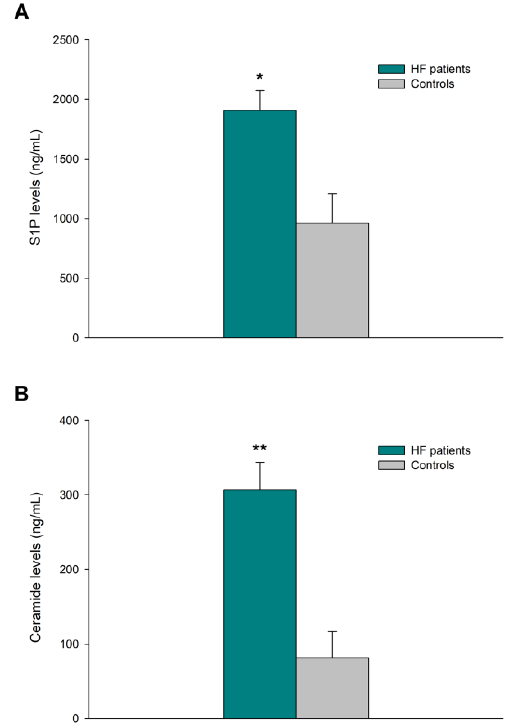
Figure 3. Differential expression of bioactive sphingolipids in cardiac tissue. ( A ) Sphingosine-1-phosphate (S1P) and ( B ) ceramide levels in heart failure (HF) and healthy controls. Data are presented as the mean ± standard error. HF patients ( n = 36; green bars) and controls subjects ( n = 5; gray bars). Mann–Whitney U test: * p < 0.05, ** p < 0.01 vs. the control group. Table 2. Relationships between mRNA expressions of sphingolipid metabolism genes, sphingolipid levels, and ventricular parameters in heart failure patients. LV Mass LVESD